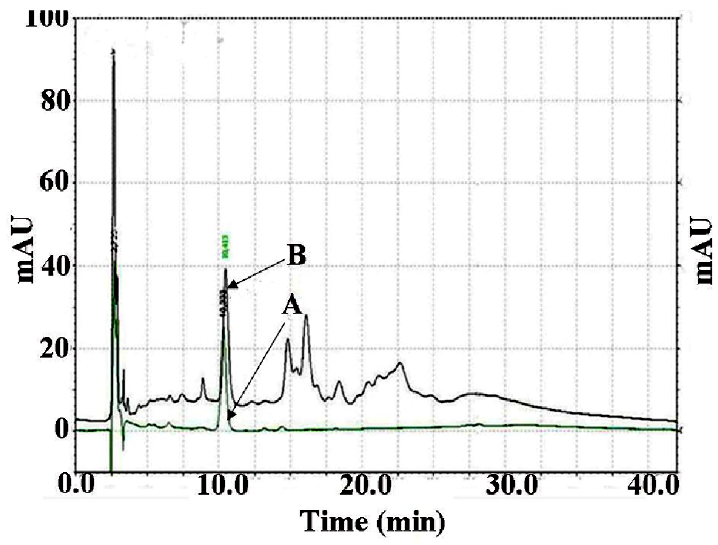
Figure 6. HPLC chromatograms of the reference standard